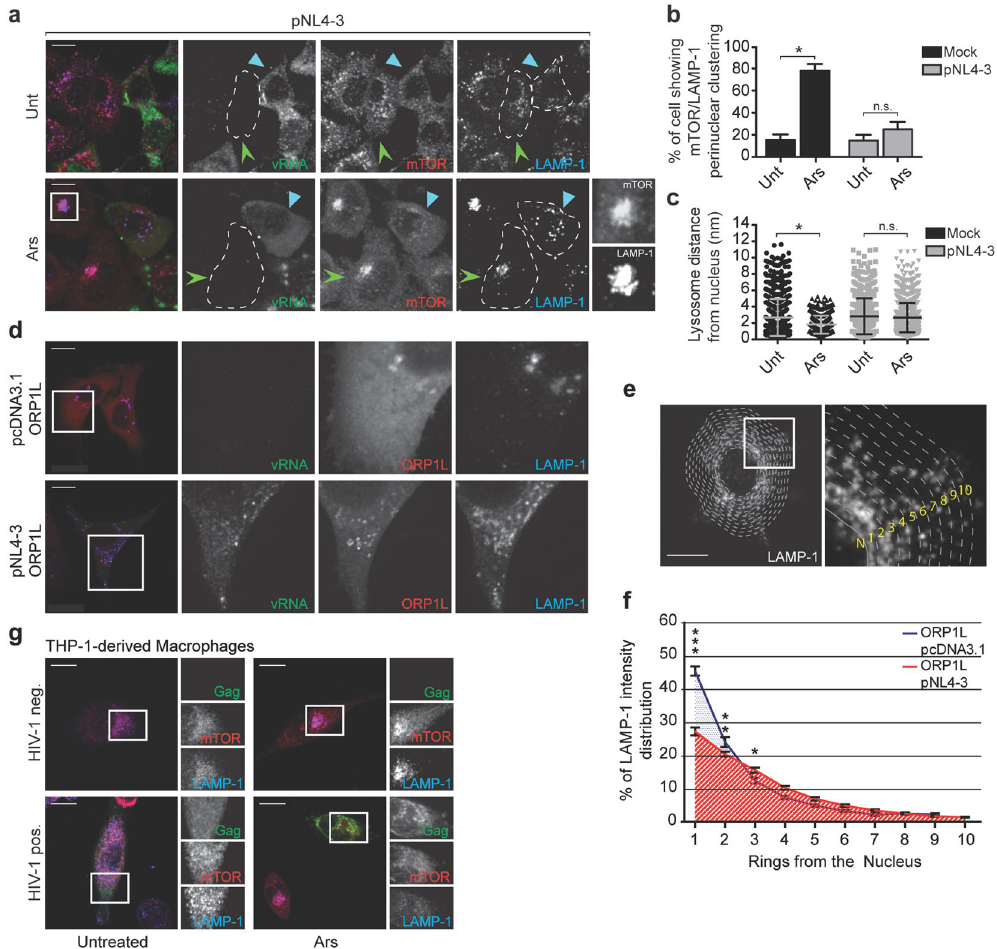
Figure 4. HIV-1 redistributes LEL. ( a ) HeLa cells were transfected with either pcDNA3.1 (not shown) or pNL4-3 and left untreated of stressed with 500 µ M Ars. HIV-1-expressing cells were identified using fluorescence in situ hybridization (FISH) to localize vRNA and stained using antibodies against mTOR (Cell Signaling 7C10) and LAMP-1. Light blue arrowheads identify HIV-1-expressing cells, while HIV-1-negative cells in the same field are indicated with green arrowheads. A dashed line contours individual cells. Scale bars are 10 μ m. ( b ) The percentage of mock or HIV-1-transfected cells showing perinuclear clustering of mTOR/ LAMP-1 from panel a. The results are presented as the mean ± S.D. from three different experiments. P value is indicated by * (p < 0.05); n.s.: no signifcant difference between the means. ( c ) The distance of lysosomes from the nucleus was quantified from at least 60 cells using the Spots Tool in Imaris software. The results are presented as the mean ± S.D. from three different experiments. P value is indicated by * (p < 0.05). ( d ) HeLa cells were co-transfected with either pcDNA3.1 or pNL4-3 and mRFP-ORP1L. HIV-1-expressing cells were identified using FISH to localize vRNA and stained for LAMP-1. Scale bar is 2 μ m. ( e ) Diagram of the quantification analysis of the immunofluorescence intensity of LAMP-1 in concentric rings from the nucleus to the plasma membrane. Representative image from a pNL4-3 and mRFP-ORP1L transfected cell. ( f ) Quantitation of LAMP-1 immunofluorescence intensity in concentric rings spanning out from the nucleus in cells overexpressing mRFP-ORP1L co-transfected with either pcDNA3.1 or pNL4-3 (n = 40). Statistical significance was tested using a two-way ANOVA and P values are indicated by * (p < 0.05), ** (p < 0.01) and *** (p < 0.001). ( g ) HIV-1-expression was induced by doxycycline (2 μ g/mL) in an inducible THP-1-derived macrophage cell line for 72 h. Cells were left untreated or stressed with Ars for 1 h before fixation. HIV-1- expressing cells were identified by Gag-GFP expression and stained for mTOR (Cell Signaling 7C10) and